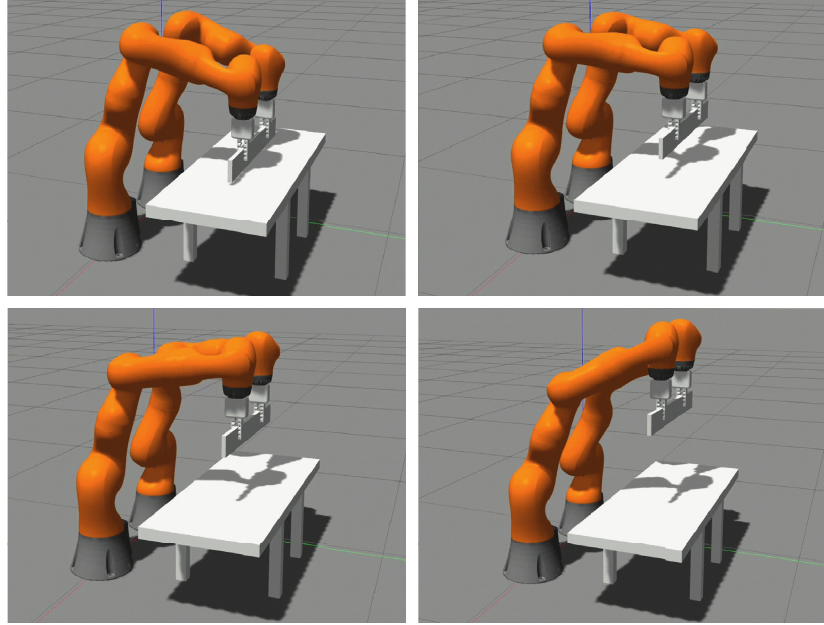
Figure 9: Gazebo transport process.